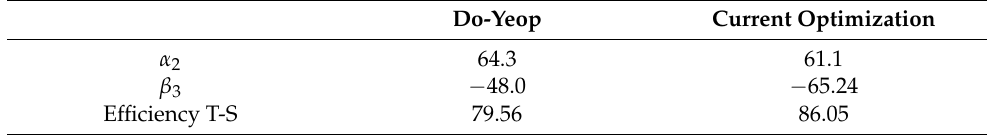
Table 5. Comparison of Do-Yeop’s [48] optimized turbine design and the current work.